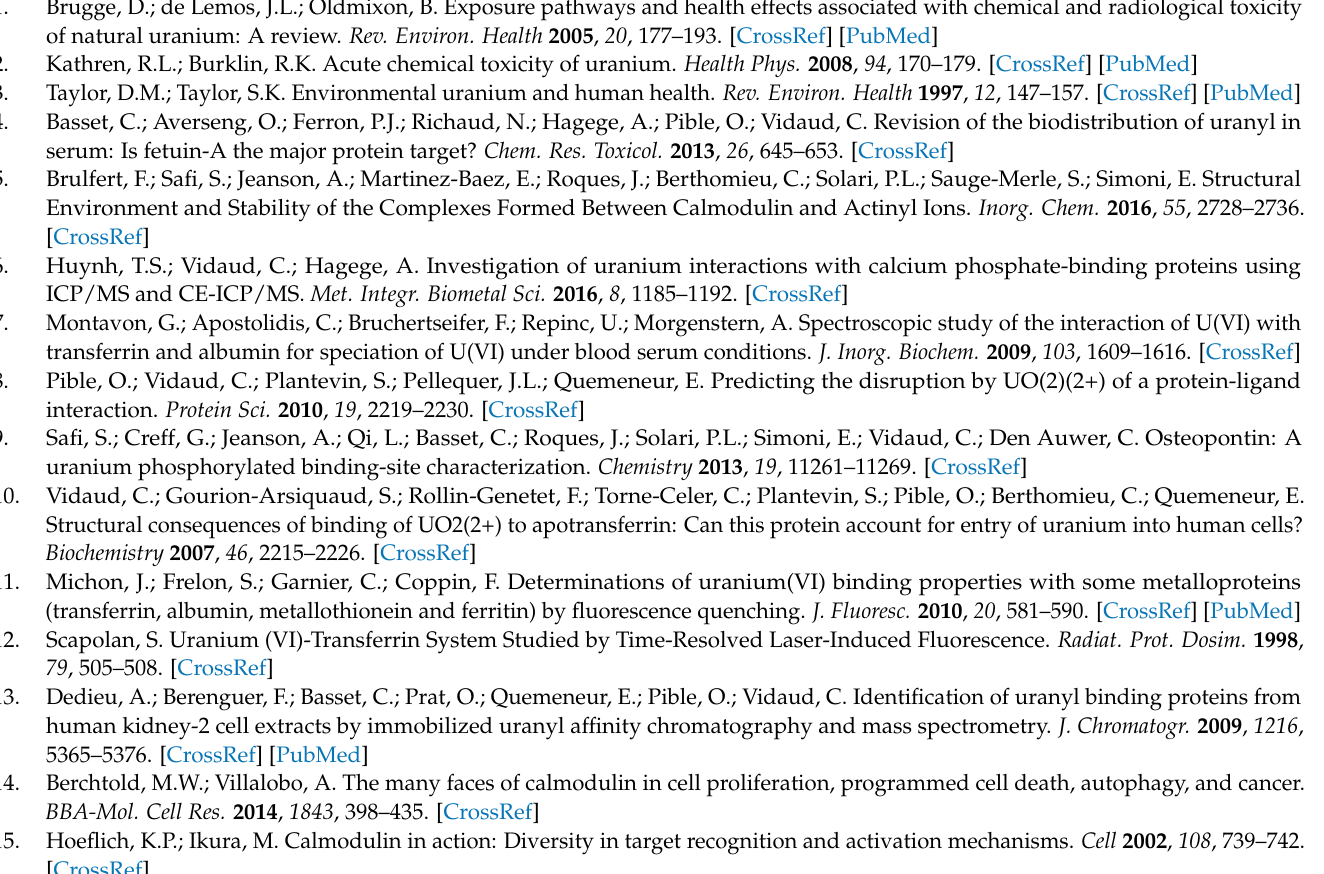
Table S1: Primers used to generate the peptide variants; Table S2: Geometric parameters obtained for the distances between site I Thr9 P P and the uranium atom of UO 22+ present at site I (U1) and at site II (U2) and for the dihedral angle of Thr9 P side-chain in the structural model resulting from the 15 ns MD simulation without restraints (No-Restr.) or starting with a structure with distance restraints (With